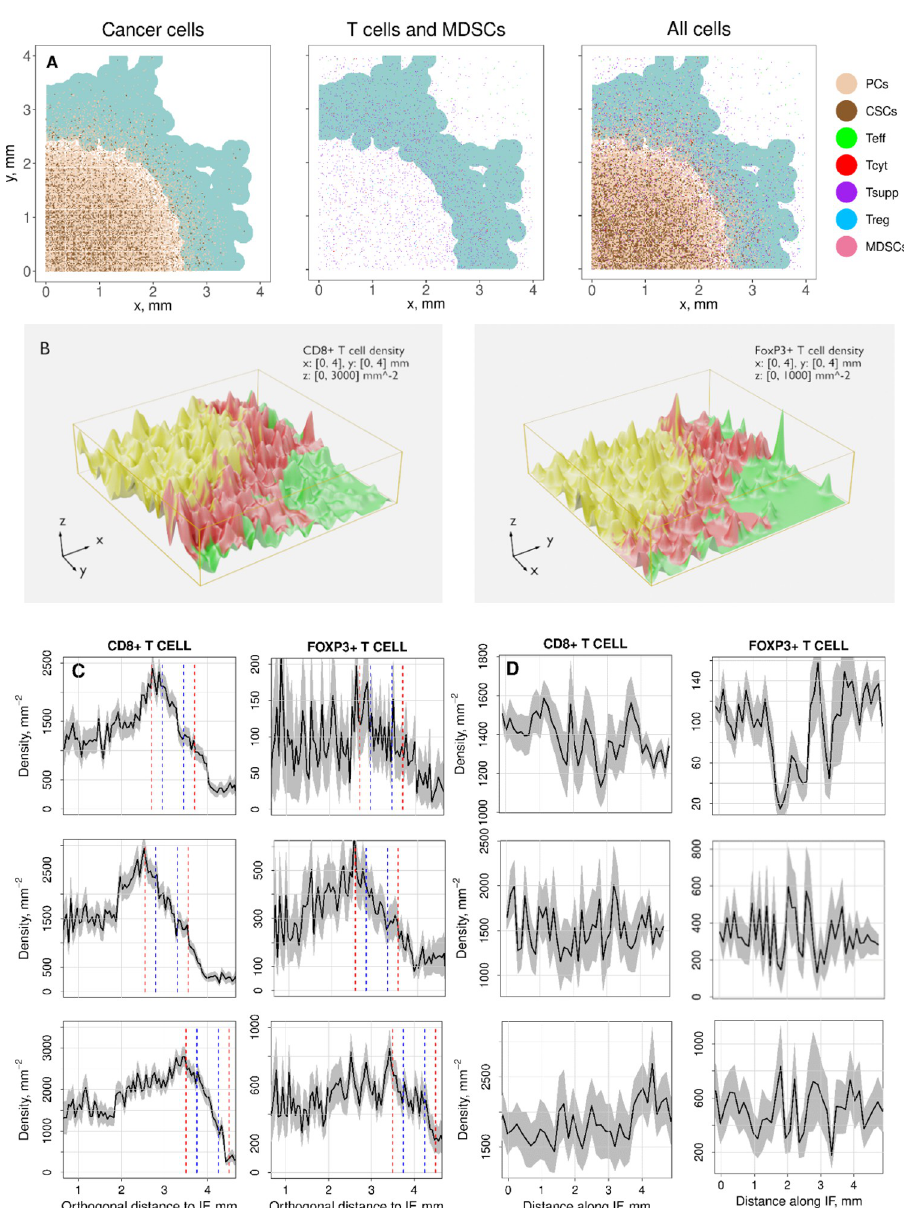
Fig 7. Cell distribution and cell density at the IF. Panel A: Spatial representation of cancer cell subtypes (left), CD8 + T cells subtypes, FoxP3+ T cells, and MDSCs (center), and all cells (right) in a section of a tumor slice. The IF region is depicted in pale turquoise. Slow tumor growth case ( k C1,growth = 0.005 day -1 ) and R << 1 (R = 1/50). Panel B: 3D representation of CD8+ T cell and FoxP3+ T cell densities in the central tumor (CT; yellow), the invasive front (IF; red), and the normal tissue (N; green). Panel C: CD8+ T cell and FoxP3+ T cell density profiles along the direction perpendicular to the IF averaged over the circumference of the IF. 95% confidence intervals are calculated (grey areas). Two definitions of IF are introduced here and are indicated as vertical lines, blue: width w pathol =0.5 mm; red: width w pathol =1 mm. Panel D: CD8+ T cell and FoxP3+ T cell density profiles along the direction perpendicular to the IF averaged over the circumference of the IF. In panels C and D every row is a case with a different combination of ratios k C1,growth /k C,T1 , k T1 /k Treg , and the parameter T reg,max , where k C1,growth , k C,T1 , k T1 , k Treg , and T reg,max are the cancer cell growth rate, the rate of cancer cell death by T cells, the exhaustion rate of cytotoxic T cells by all cells that express PD-L1, the inhibition rate of cytotoxic T cells by regulatory T cells, and the maximal regulatory T cell density in the tumor, respectively. The spatial QSP algorithm calculated the evolution of a tumor slice starting from a fraction of a normal distribution of cancer cells. QSP model and ABM are coupled before reaching the point where T cells are recruited and also before the initial tumor diameter condition from the QSP model is met. Thus, no initial T cell spatial distribution is enforced. The figures here show cell distributions and densities 6 months after the initial tumor diameter condition is met.